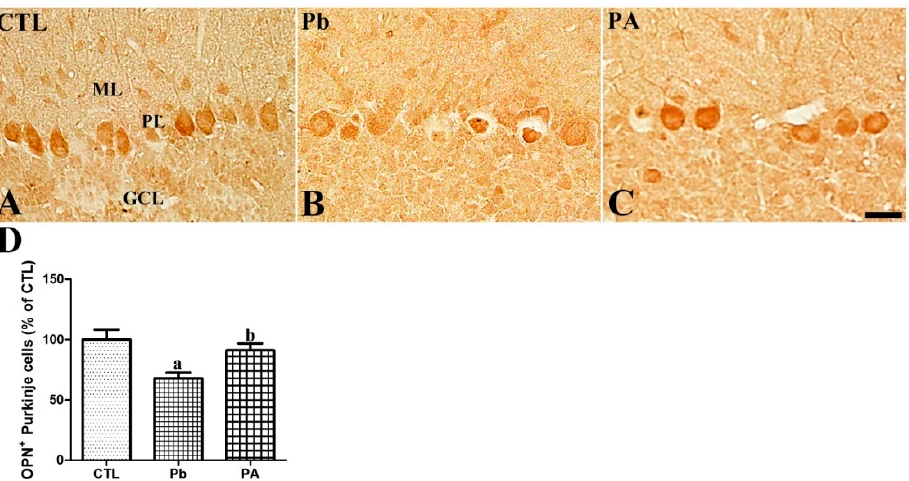
Figure 3. Immunohistochemistry for osteopontin (OPN) in the cerebellum ( A – C ) of offspring from CTL, Pb, and PA groups. GCL, granule cell layer; ML, molecular layer; PL, Purkinje cell layer. Bar = 25 µ m. ( D ) The numbers of OPN-positive Purkinje cells in the cerebellar cortex are expressed as percentages of the value in the CTL group ( n = 12 offspringper group; a p < 0.05, indicating a significant difference compared with the control group, b p < 0.05, indicating a significant difference compared with the Pb group). The bars indicate the means ± standard errors of the mean.